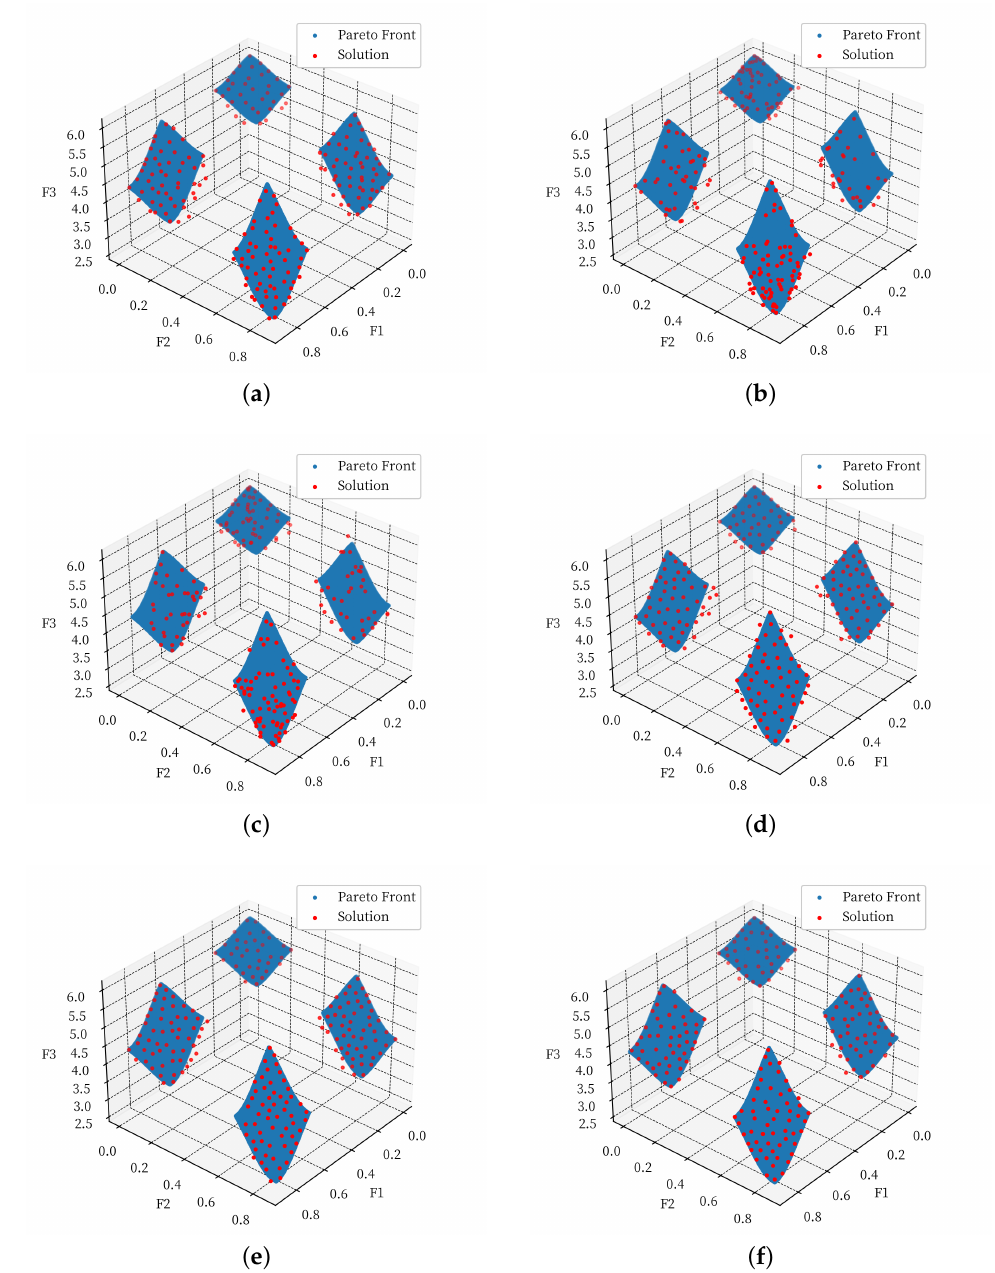
Figure 8. Comparison Between the Pareto Front and the Final Population Solution Set Ob- tained by the Six Different Algorithms on DTLZ7 Test Problem Set. Subfigures ( a ) AGEMOEA, ( b ) MOEA/D-URAW, ( c ) NSGA-II-SDR, ( d ) CMOPSO, ( e ) MOEA/D-DAE, and ( f ) MOEA/D-DPAW correspond to the running results of algorithms AGEMOEA, MOEA/D-URAW, NSGA-II-SDR, CMOPSO, MOEA/D-DAE, and MOEA/D-DPAW,